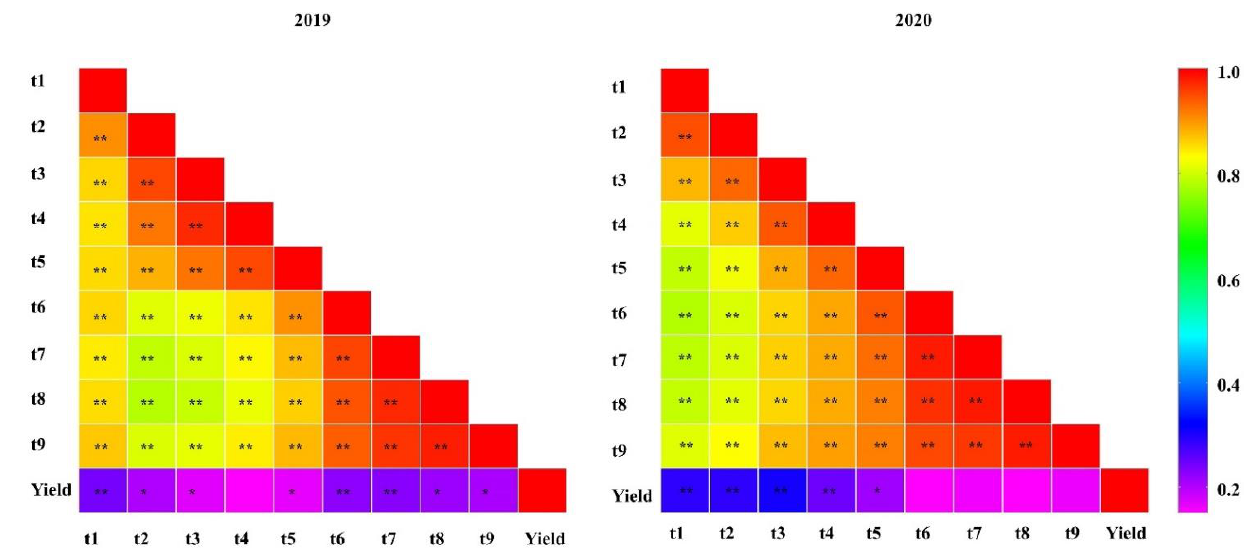
Figure 4. Analysis of the correlation between tiller number at each measuring stage and yield in the CNDH population in 2019 and 2020. ** Correlation is significant at the 0.01 level (2-tailed); * correlation is significant at the 0.05 level (2-tailed).